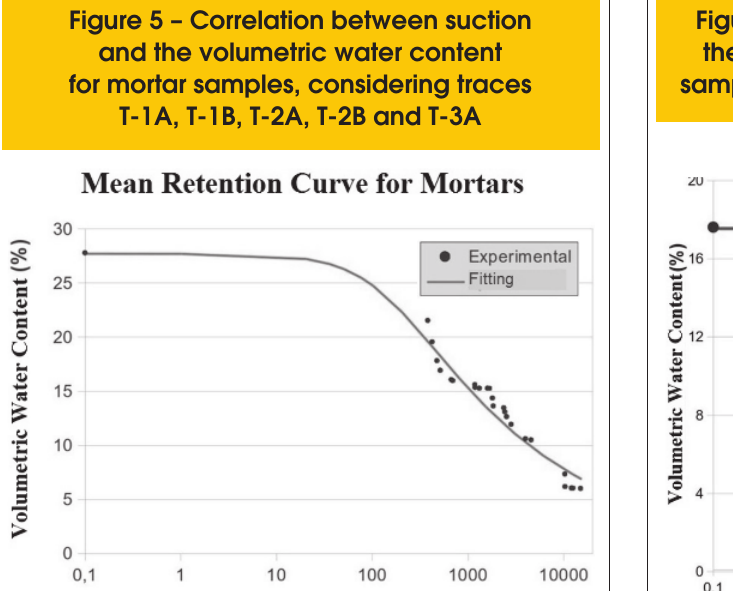
Figure 5 – Correlation between suction and the volumetric water content